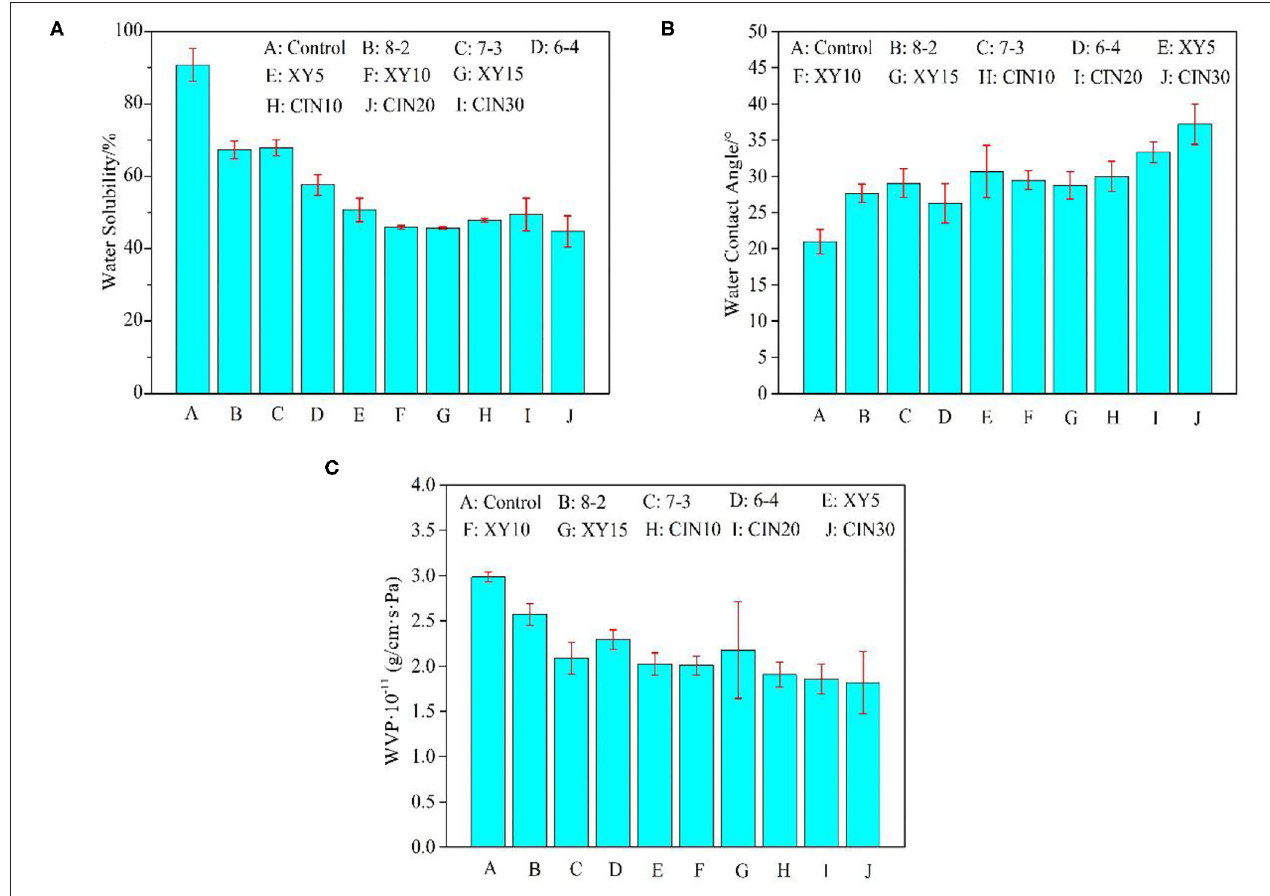
FIGURE 6 | (A) Water solubility (WS), (B) water contact angle (WCA), and (C) water vapor permeability (WVP) of GP-based composite